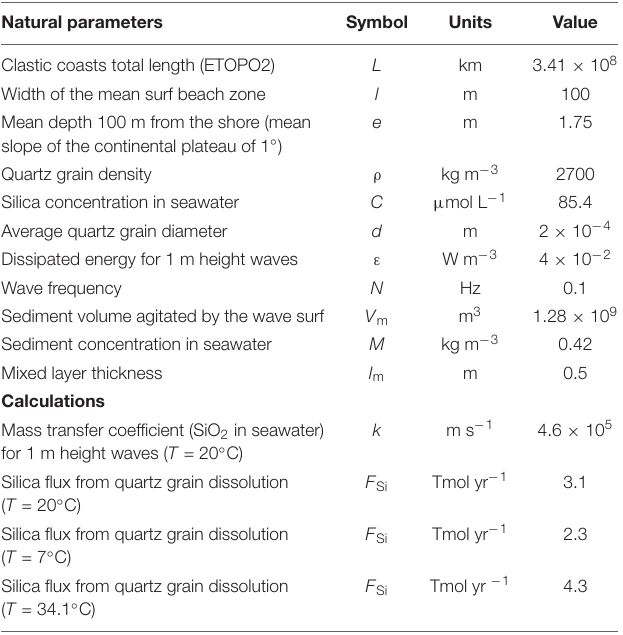
TABLE 6 | Calculated silica fluxes from the beach to the offshore caused by quartz grain